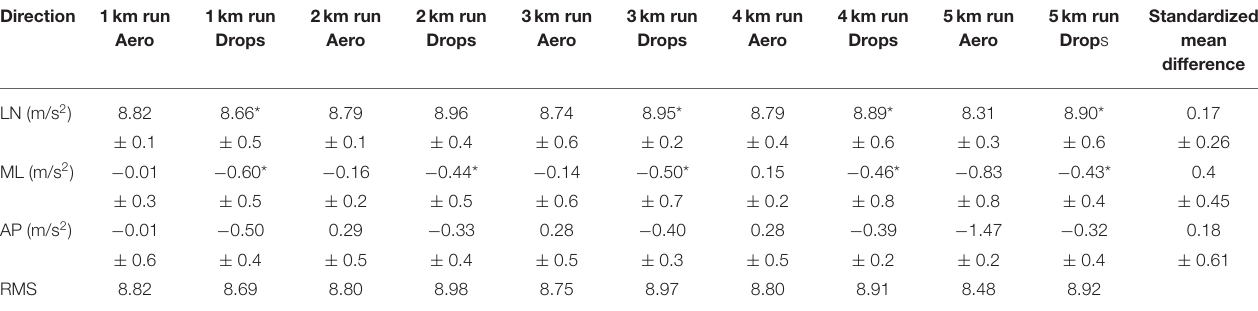
TABLE 5 | Descriptive statistics for magnitude of mean ± SD longitudinal and mediolateral torso acceleration in running after aero and drops cycling (in m/s 2 ). Direction 1km run